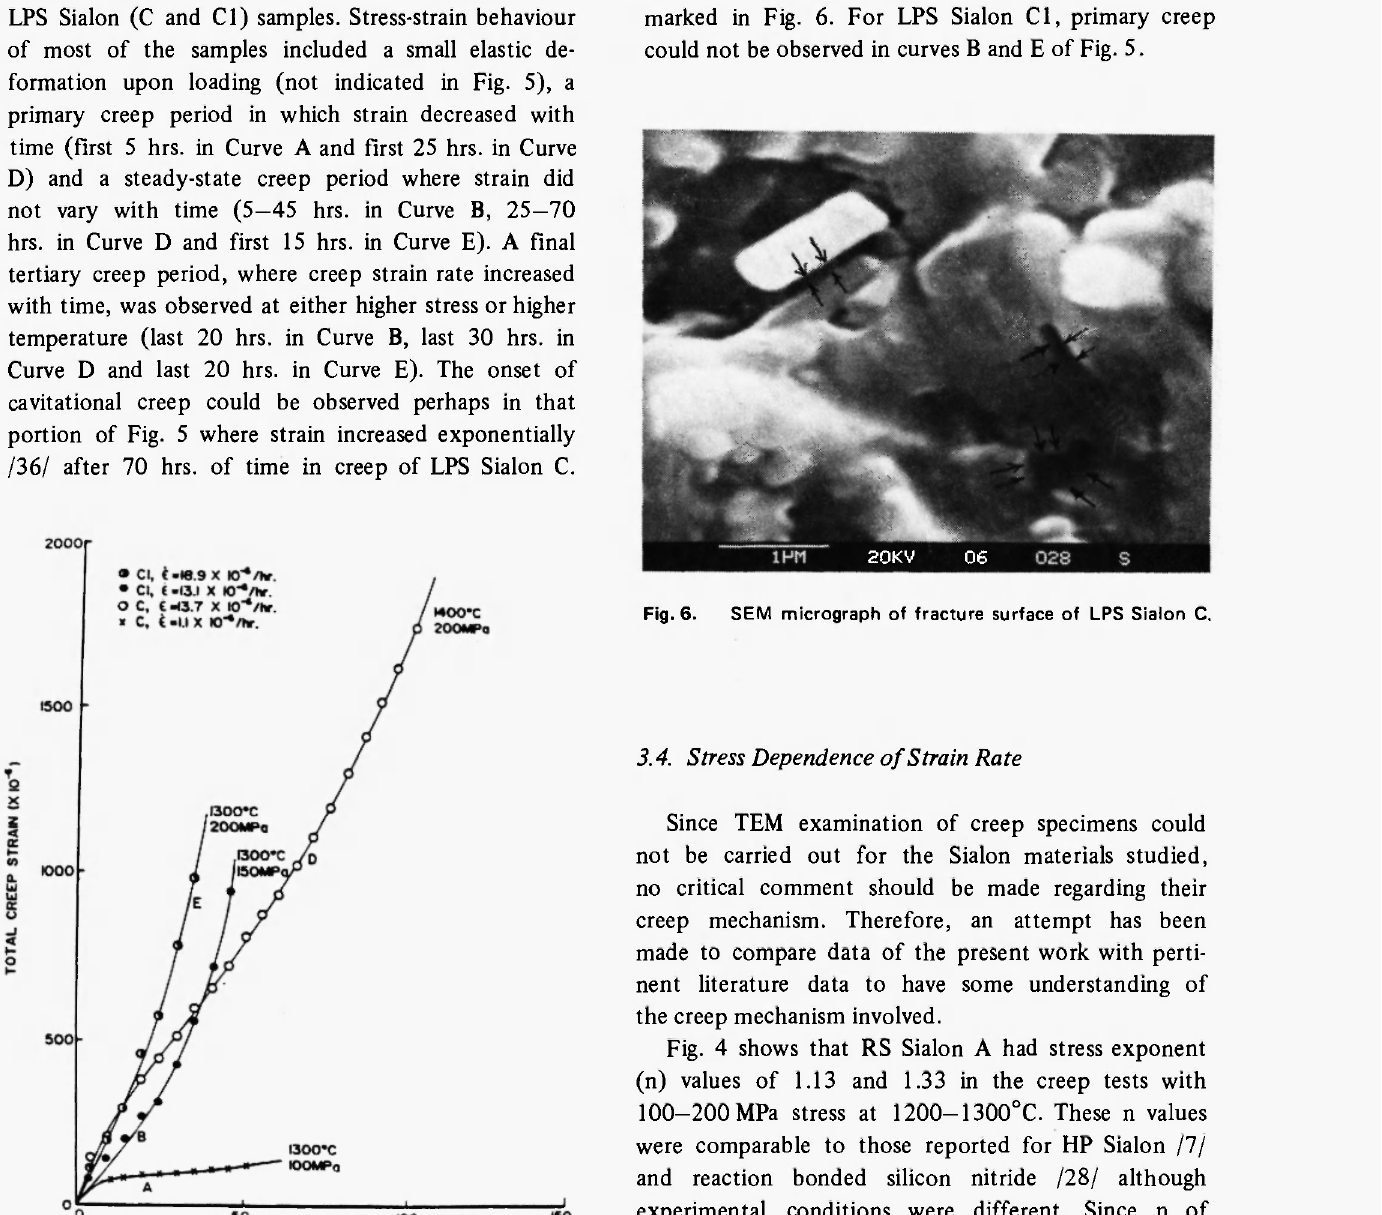
Fig. 5. Relationship between total creep strain and time of LPS Sialon C and C1.